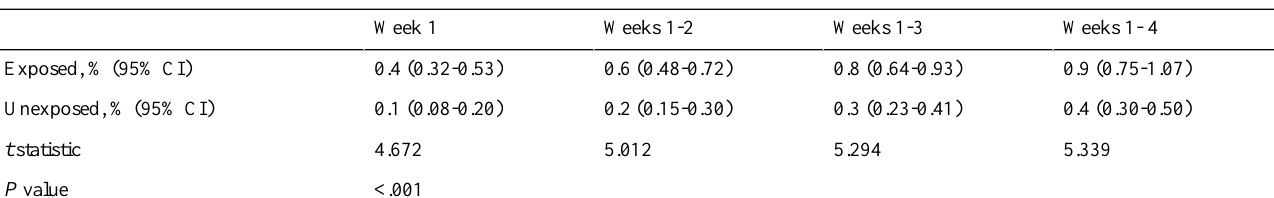
Table 3. Visits to CDC Tips